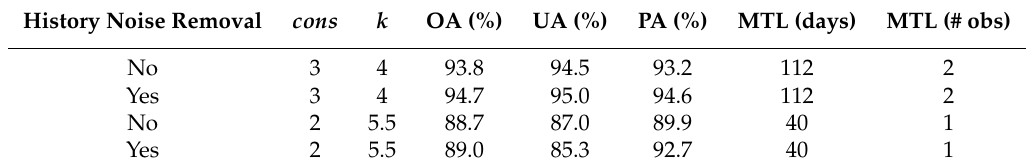
Figure 7. Spatial accuracy (( a – c ), OA: overall accuracy; PA and UA: producer’s and user’s accuracies of the deforestation class), and temporal accuracy (( d – f ), MTL: median temporal lag of confirmed deforestation events) of the proposed deforestation detection algorithm, as a function of increasing values of k , separately for cons = 1, cons = 2, and cons = 3. The accuracies were assessed with 435 reference samples. k controls the decision boundary of anomaly detection (Equation (1)), cons is the number of consecutive anomalies required to confirm a deforestation event. Table 1. Deforestation detection accuracies of the proposed algorithm assessed with 435 reference samples. cons is the number of consecutive anomalies required to confirm a deforestation event. k is the factor which controls the decision boundary of anomaly detection (Equation (1)). MTL is the median temporal lag between the date of deforestation event confirmed by the algorithm, and reference date, given in number of days and number of observations. NA: not applicable. OA is overall accuracy, UA and PA are user’s and producer’s accuracies of deforestation